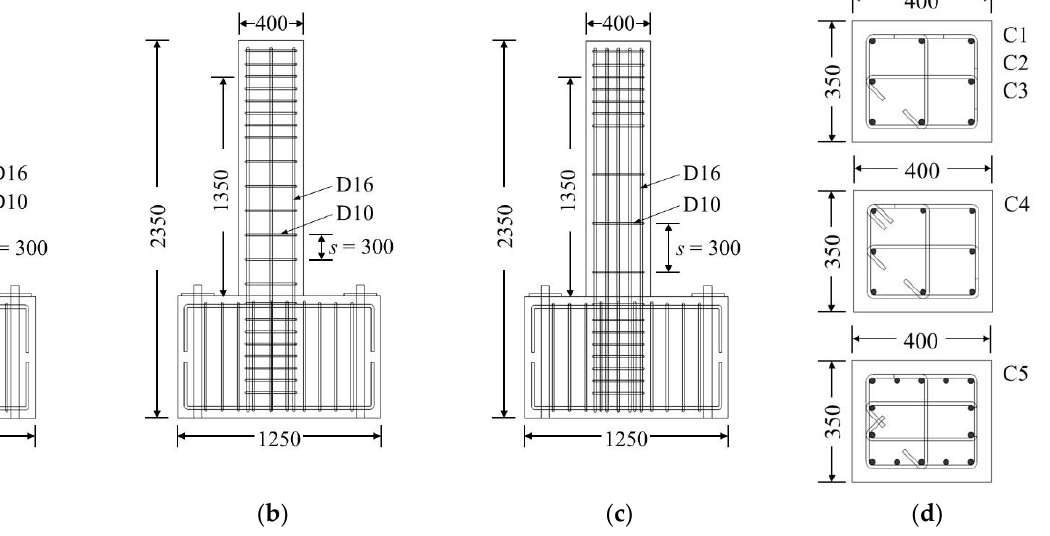
Figure 1. Details of longitudinal and transverse reinforcement for column specimens (all dimensions in mm): ( a ) C1, C2, and C4; ( b ) C3; ( c ) C5; ( d ) Cross-sections.